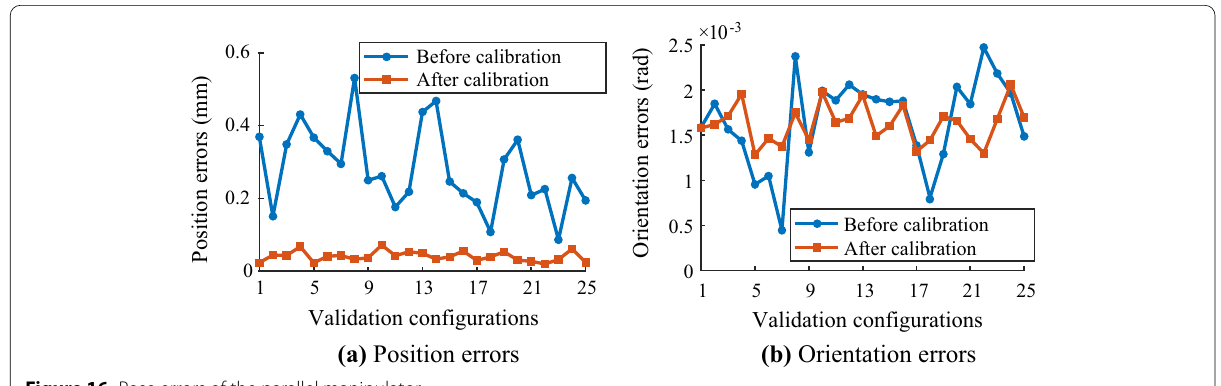
Figure 16 Pose errors of the parallel